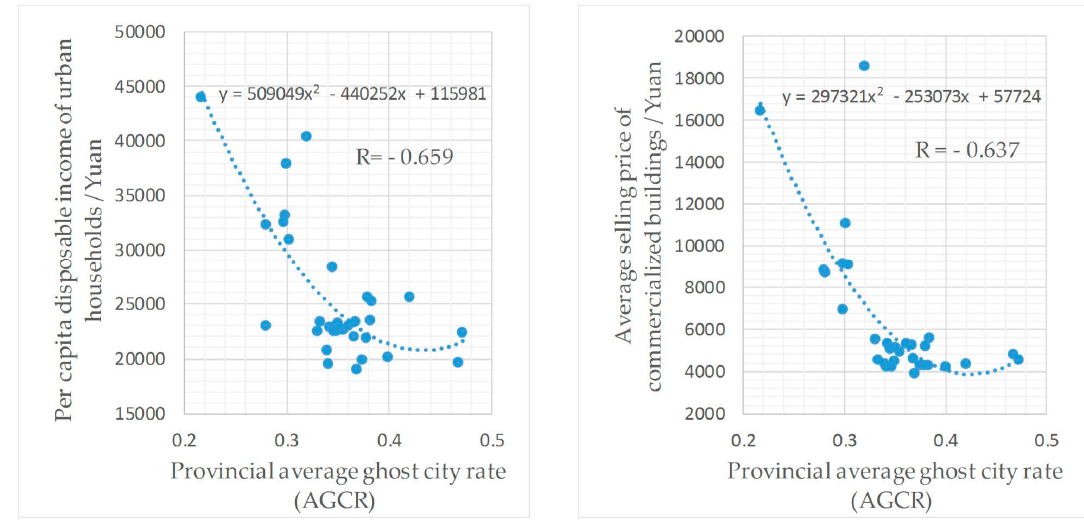
Figure 5. The scatter plots between 31 provincial AGCRs with the per capita disposable income of urban households and the average selling price of commercial buildings in China.